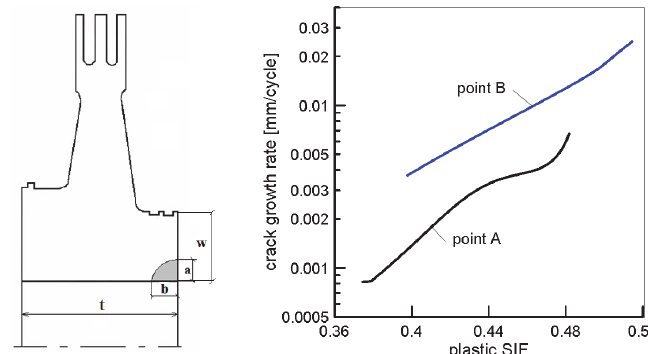
Figure 8: Crack growth rate as a function of plastic SIF.